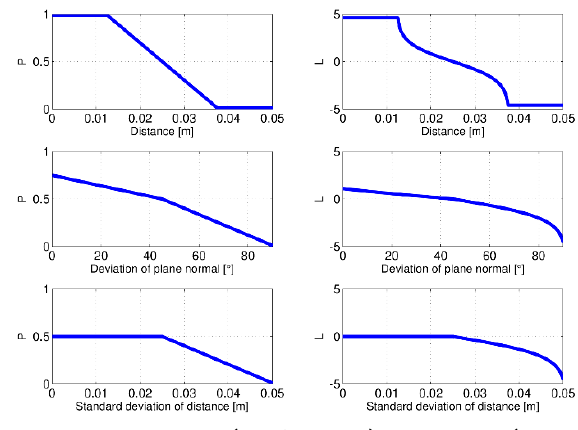
Figure 3. Probabilities (P, left column) and log-odds (L, right column) for the three criteria distance, normal deviation and standard deviation of distance